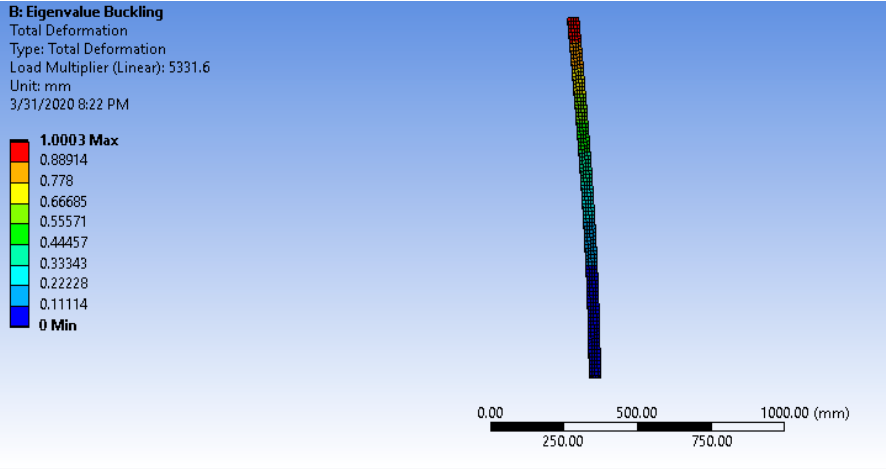
Figure 6. The first mode of buckling failure was the gross-buckling of the GRCC along the weak axis.